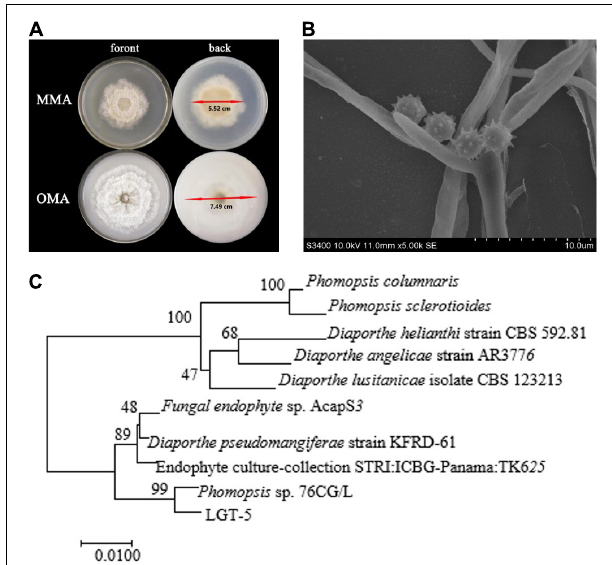
FIGURE 4 | The images of strain growth, mycelium, and phylogenetic tree of Phomopsis sp. LGT-5. (A) Strain cultured with MMA and OMA medium; (B) Hyphae morphology from SEM scanning; (C) Evolutionary tree of Phomopsis sp.